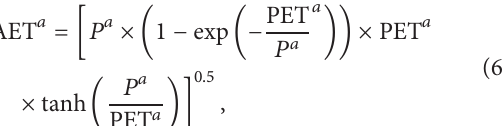
Figure 4: K-S D value of water budget by different distribution